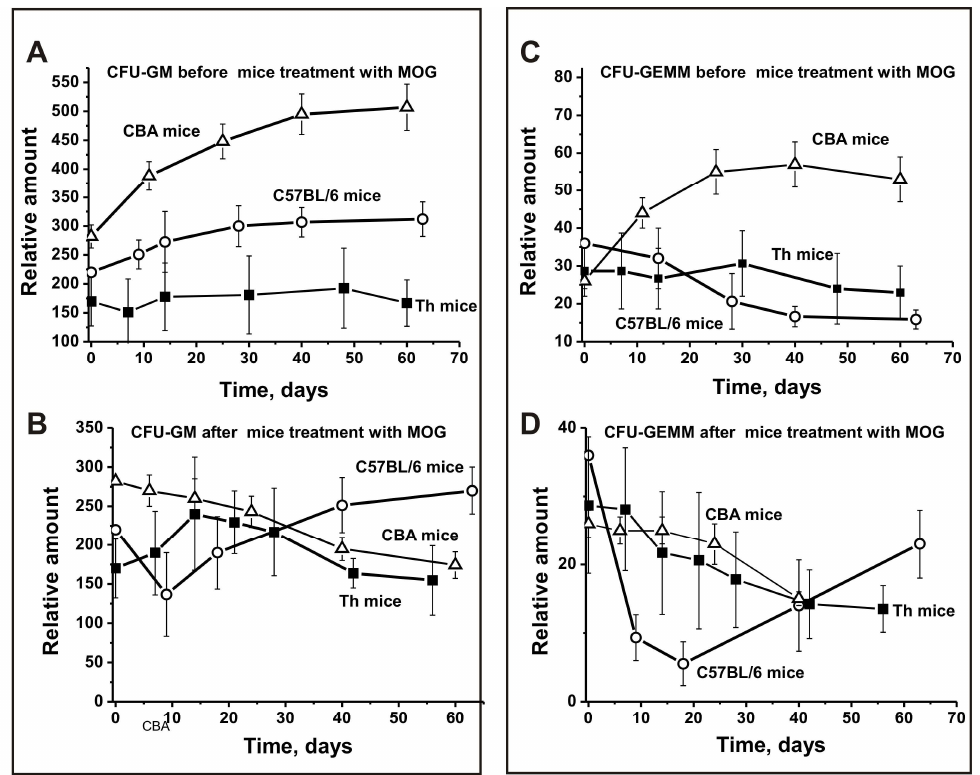
Figure 3. Changes over time in the number of mouse brain CFU-GM ( A , B ) and CFU-GEMM ( C , D ) cells before and after MOG treatment of C57BL/6, CBA, and Th mice. CFU-GM: granulocytic-macrophagic colony-forming unit; CFU-GEMM: granulocytic, erythroid, myeloid colony-forming